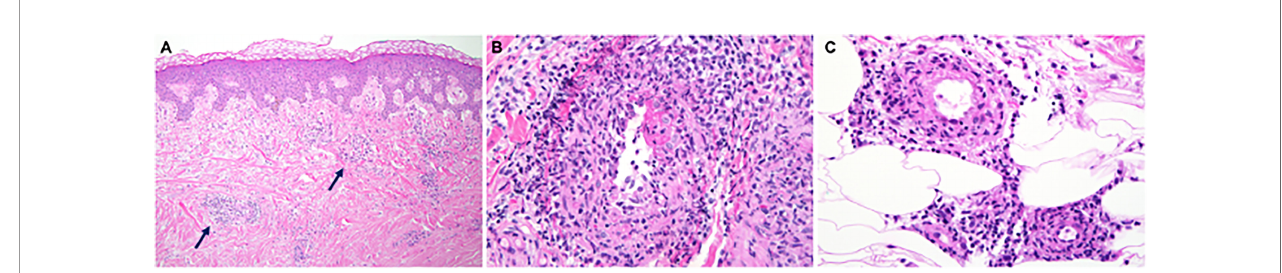
FIGURE 3 | The medium vessel vasculitis in DADA2 patients resembles the vasculitis in polyarteritis nodosa. (A) Sections of skin biopsy showing lymphovascular occlusion in medium vessels in the medium-to-deep dermis with in fl ammatory in fi ltrate with neutrophils and intravascular thrombi. (B) Vasculitis of a medium sized artery characterized by dense transmural in fi ltrate of mononuclear cells and neutrophils with karyorrhexis, fi brin deposits in vascular lumen, destruction of vessel walls and dense chronic in fl ammation surrounding the affected blood vessel. (C) Vasculitis involving smaller blood vessels of the super fi cial subcutis. This biopsy was interpreted as possible